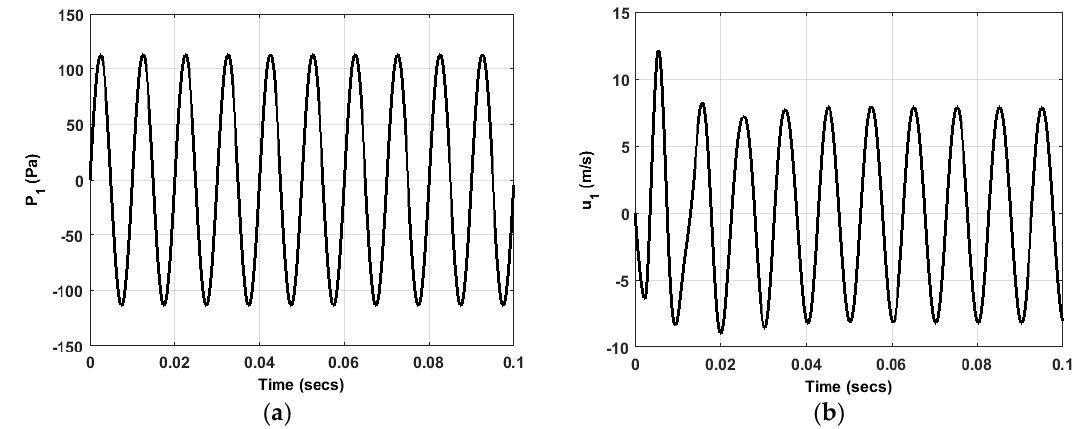
Figure 5. Amplitudes of ( a ) pressure, P 1 ( b ) velocity, u 1 at oscillating boundary.